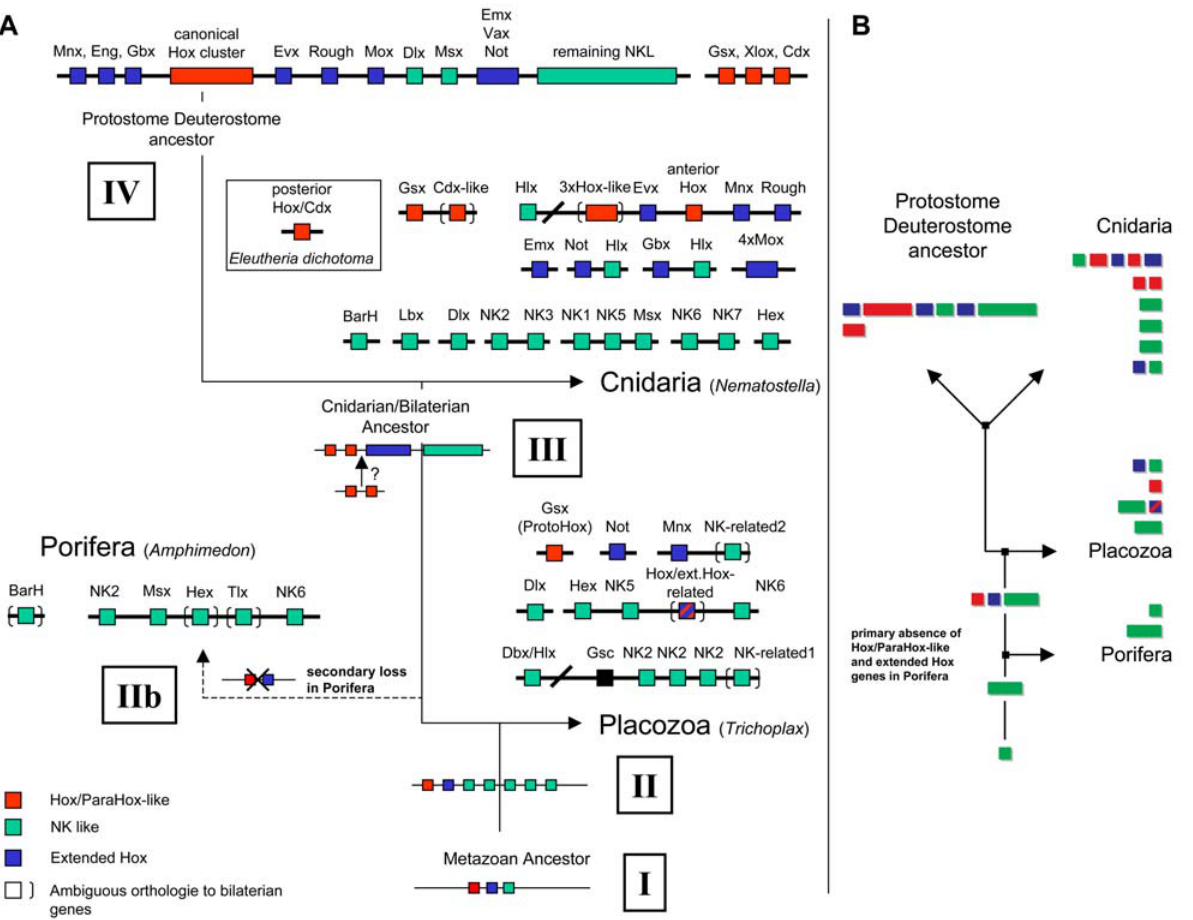
Figure 1. Two possible scenarios for the evolution of the ANTP superclass in Metazoa. A : The Placozoa basal scenario. I The metazoan ancestor may have already possessed clustered single representatives of NKL, extended Hox and Hox/ParaHox-like genes. II Expansion of the NKL subclass. This situation is exemplified by the ANTP gene complement in Trichoplax adhaerens , which harbors several clustered NKL genes, two genes of the extended Hox and a single Hox/ParaHox-like gene which is a true Gsx ortholog and may be the founder of the Hox/ParaHox-like subclass of ANTP genes. IIb Based on the assumption that Placozoa are basal within extant metazoan phyla, Porifera must have lost extended Hox, Hox/ParaHox- like and some NKL genes. An alternative scenario that Porifera are most basal would in turn require loss of some NKL genes in Placozoa (e.g. Msx and Bar/Bsh related genes). III Further expansion of ANTP genes in a cnidarian-bilaterian ancestor leading to almost complete repertoires of NKL and extended Hox genes. Occurrence of anterior Hox and posterior Hox/Cdx-like genes. The assumption that a Gsx type gene was the founder of Hox/ ParaHox-like genes requires that Gsx and a posterior Hox/Cdx-like gene were part of an ancestral ANTP mega-array for which we still lack any evidence in extant species (question mark in III). In urochordates, however, we find one example of a ParaHox gene (Cdx) which is tightly linked to a Hox gene [23]. IV occurrence of a true canonical Hox System and complete ParaHox cluster in Bilateria. Linkages other than for Trichoplax adhaerens are based upon[11,13,15,16]. In the case of Nematostella some linkages have been deduced from the current JGI genome assembly. The proposed ANTP mega-array in a cnidarian-bilaterian ancestor has been deduced from [7,8,10,12,15]. Remark: For completeness the black square in the Trichoplax genome represents the PRD class gene Gsc which is tightly linked to NKL genes. B : A Porifera basal scenario (simplified) for the Evolution of ANTP genes leading to crown group diploblasts and a putative protostome deuterostome ancestor: starts with a single (proto)NK gene and an initial expansion of the NKL subclass. Hox/ParaHox-like and extended Hox genes are an invention of the lineage leading to Placozoa, Cnidaria and Bilateria.